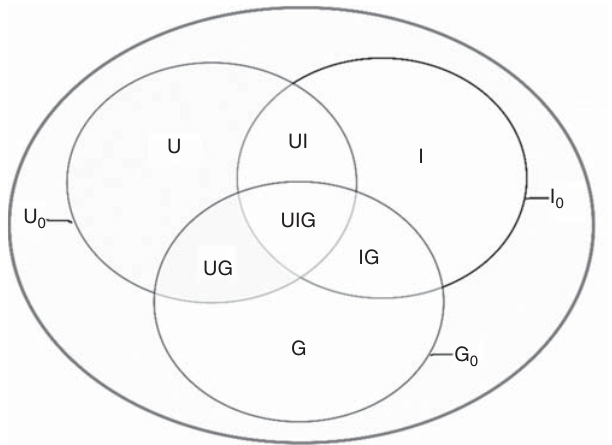
Figure 1. Triple Helix spheres